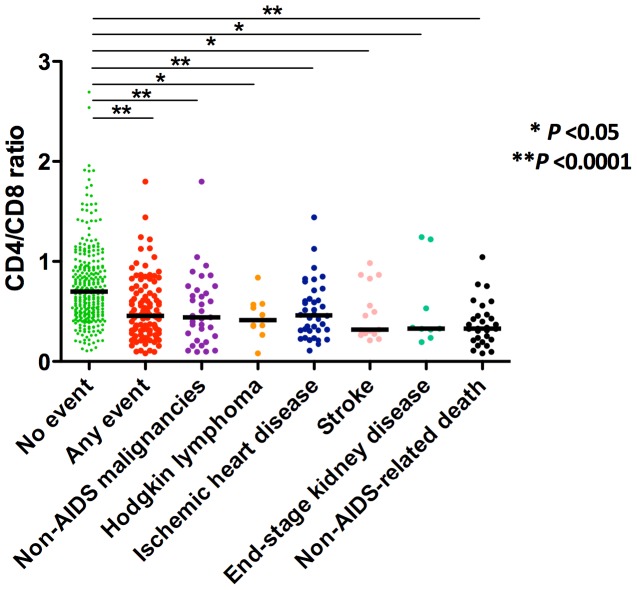
CD4/CD8 ratio according to the presence and type of event.The CD4/CD8 in controls [0.70 (IQR 0.48–0.94)] was significantly higher than in subjects who developed non-AIDS events [0.46 (IQR 0.31–0.68), P<0.0001], including non-AIDS defining malignancies (N = 35) [0.44 (IQR 0.25–0.71), P = 0.0001], Hodgkin lymphoma (N = 10) [0.41 (IQR 0.33–0.57), P = 0.0039], ischemic heart disease (N = 38) [0.47 (IQR 0.32–0.63), P = 0.0001], stroke (N = 15) (0.46 [IQR 0.28–0.83), P = 0.013), and end-stage kidney disease (N = 9) [0.33 (0.32–0.53), P = 0.028]. The CD4/CD8 ratio was also significantly lower in subjects with non-AIDS associated mortality (N = 29) [0.33 (IQR 0.22–0.46), P<0.0001].